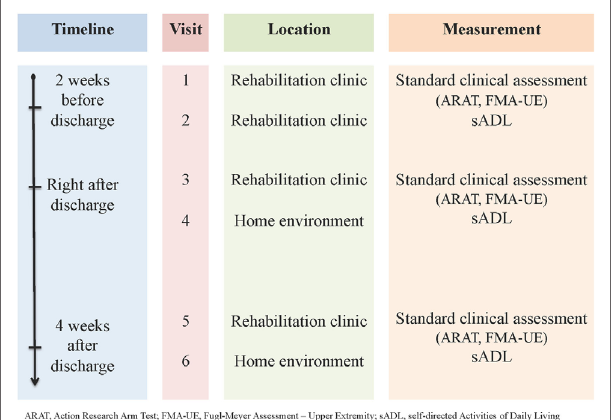
FigUre 1 | Overview of visits and assessments. ARAT, Action Research Arm Test; FMA-UE, Fugl-Meyer Assessment––Upper Extremity; sADL, self- directed Activities of Daily